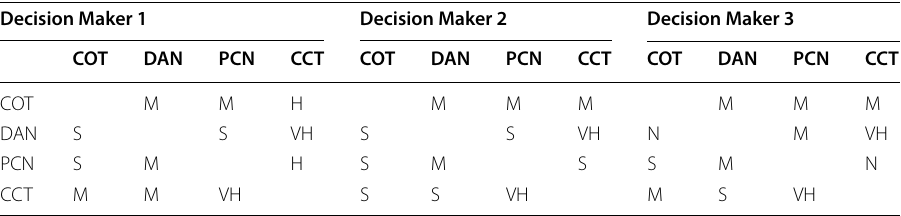
Table 3 Linguistic evaluations for the criteria Decision Maker 1